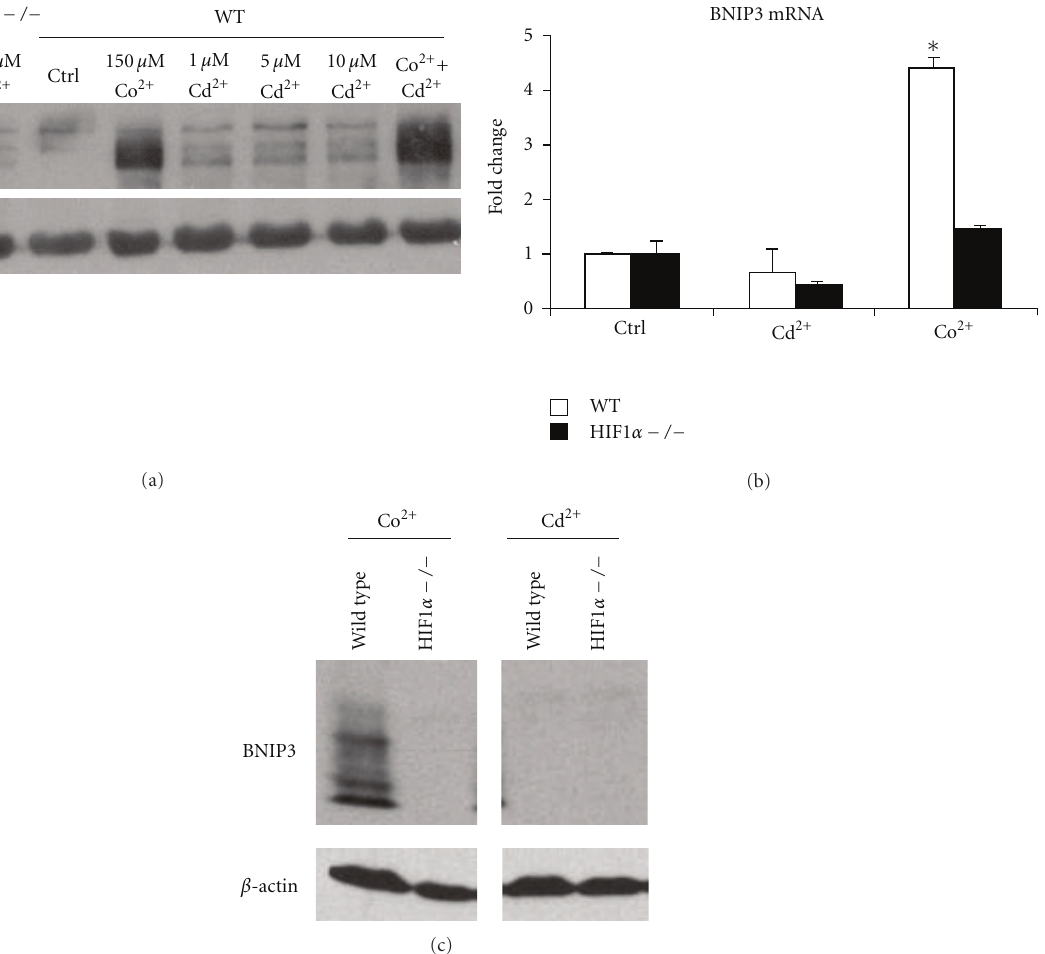
Figure 2: Hypoxia signaling and cytotoxicity to CdCl 2 . (a) Wild-type (WT) cells were left untreated (Ctrl) or exposed to 150 μ M CoCl 2 (Co 2+ ), 1, 5 or 10 μ M CdCl 2 (Cd 2+ ) or 150 μ M CoCl 2 and 10 μ M CdCl 2 for 24 hours. HIF1 α − / − cell extract treated with 150 μ M CoCl 2 was used as a negative control. Nuclear protein was extracted and separated by SDS-PAGE, transferred to nitrocellulose membrane and probed with a HIF1 α (upper panel) or β -actin (lower panel) specific antibody. The bands observed in the cadmium only WT cells are nonspecific as they are also observed in the HIF1 α − / − cells. (b) BNip3 mRNA expression levels were analyzed by qRT-PCR in wild type (WT, white bars) and HIF1 α − / − cells (black bars). Cells were left untreated (0), or exposed to 5 μ M CdCl 2 (Cd 2+ ) or 150 μ M CoCl 2 (Co 2+ ) for 24 hours. Each value was normalized to the control level in the corresponding cell line. ∗ P < 0 . 05 compared to the corresponding controls, n = 4. (c) BNIP3 protein levels were determined in wild type and HIF1 α − / − cells after treatment with 150 μ M CoCl 2 (Co 2+ ) or 5 μ M CdCl 2 (Cd 2+ ) for 24 hours using a BNIP3 specific antibody and β -actin was used as a loading control (lower Panel).